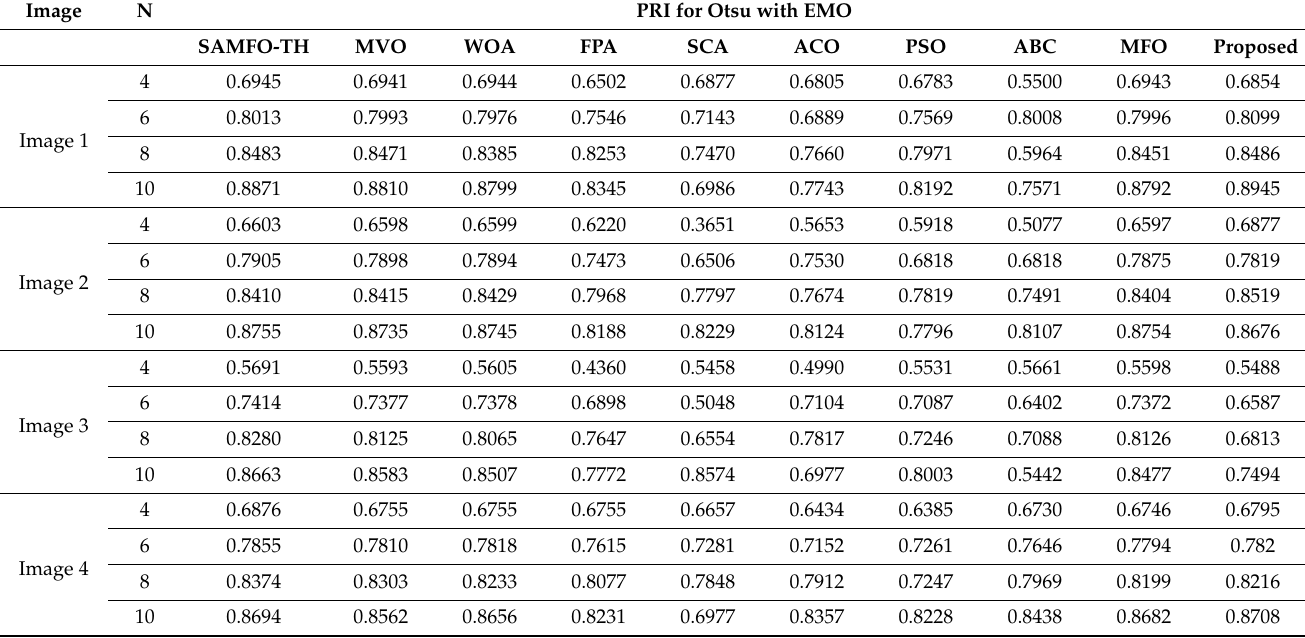
Table 13. Comparison computed by SAMFO-TH, MVO, WOA, FPA, SCA, ACO, PSO, ABC, and MFO with the proposed model using Otsu’s method with N = 4, 6, 8, and